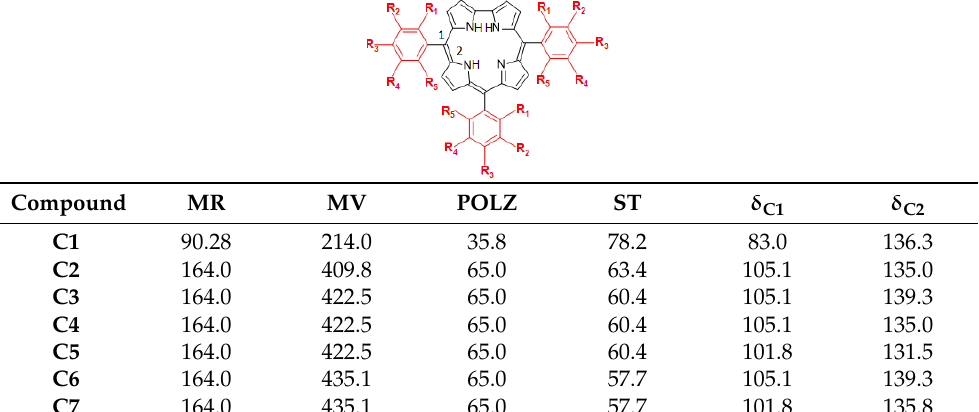
Table 4. The descriptor values of molar refractivity (MR), molecular volume (MV), polarizability (POLZ), superficial tension (ST), and 13 C nuclear magnetic resonance (NMR) shift chemical ( δ C1 and δ C2 ) for each corrole ( C1 – C17 ).